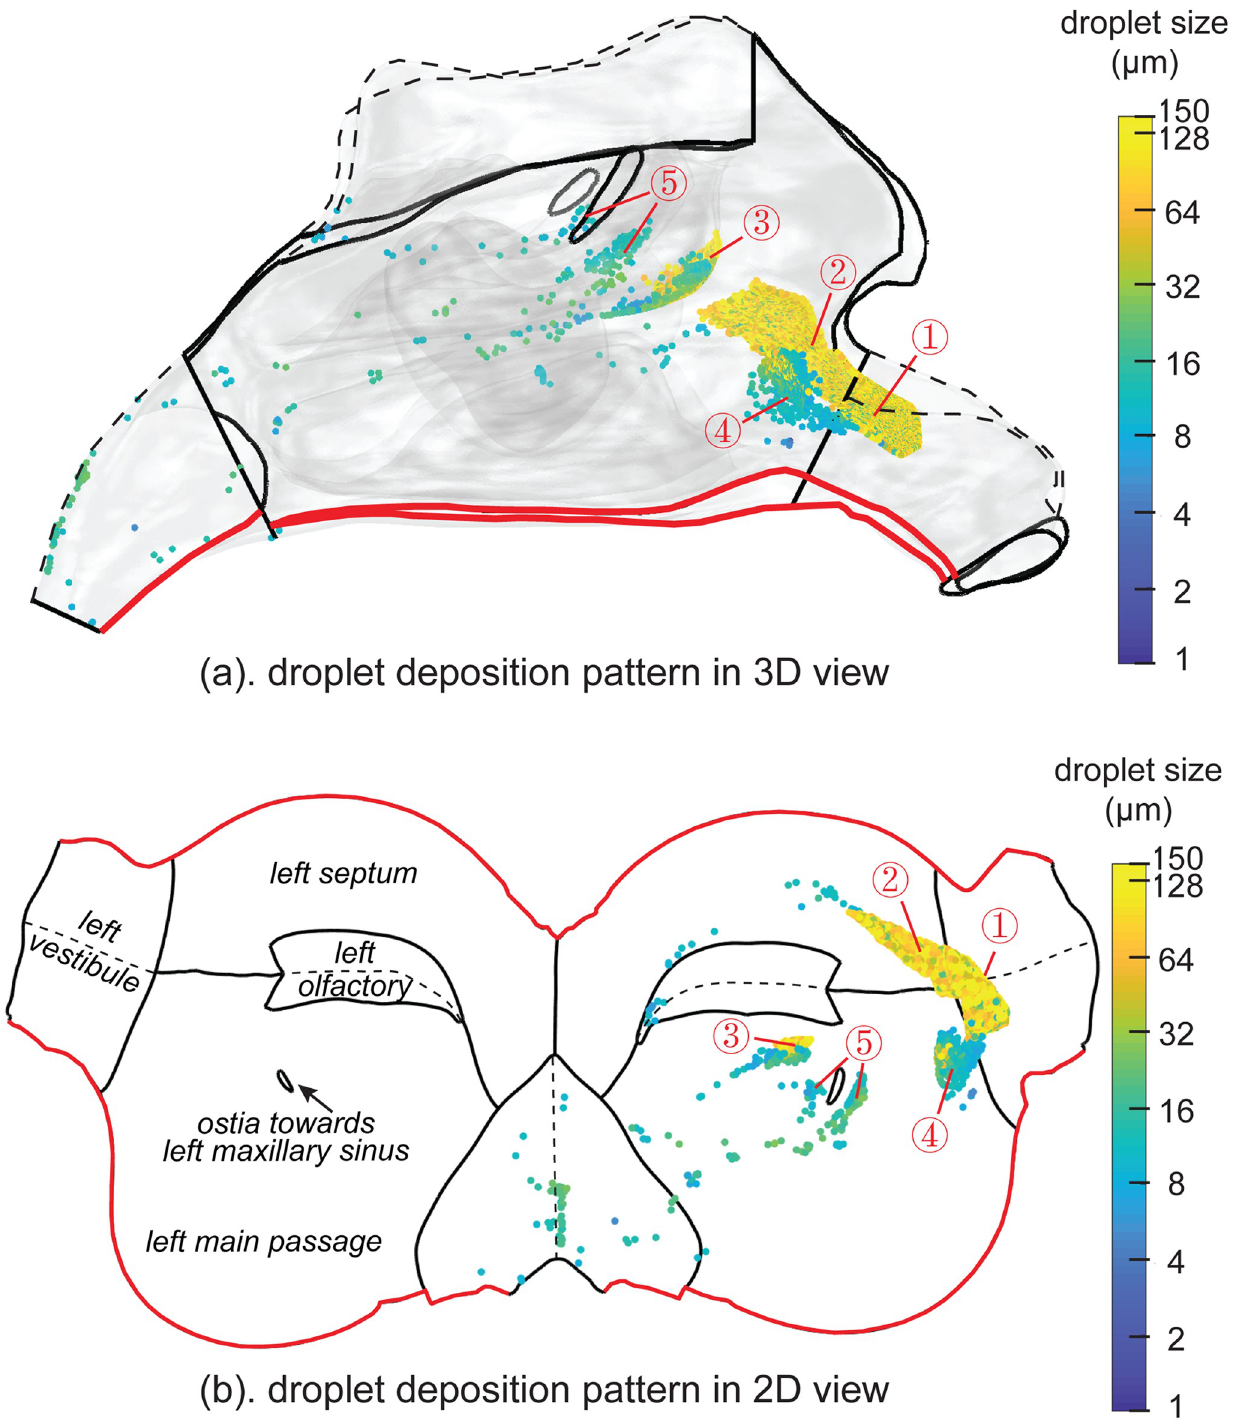
Fig 5. Particle deposition patterns coloured by particle size ranging from 1 μm to 150 μm . (a). Particle deposition distribution in 3D view of the right chamber. Nasal walls were set transparent to visualise particle deposition locations. (b). Particle distribution in the unwrapped 2D view. All deposited particles were at the right cavity where the spray particles were released. There are three hot-spots of deposition caused by direct impaction. The first hot- spot mainly depicted by large droplets with size > 30 μm was a band-like region that across vestibule and septum ( ① and ② ), the second one is located at the tip of the middle turbinate ( ③ ) and the third one mainly hosts small droplets with size < 30 μm was a more concentrated area that across vestibule and lateral cavity ( ④ ). Another deposition hot-spot for nearly 30 μm particles is located around the maxillary ostia ( ⑤ ).